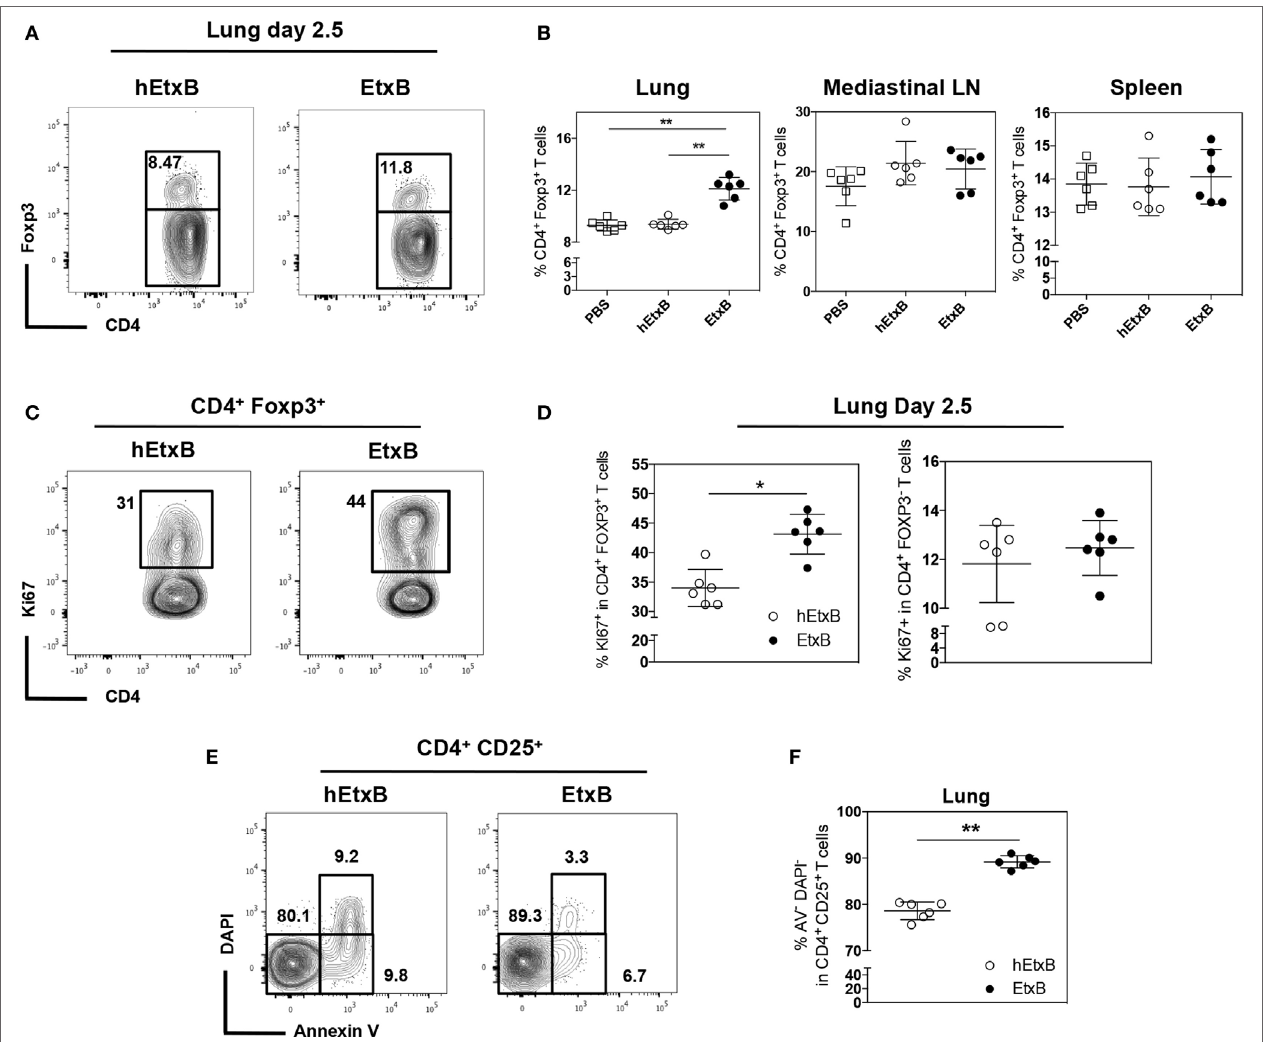
FigUre 1 | intranasal treatment of etxB increases the proliferation of Treg cells . C57BL/6 mice were administered, EtxB (100 μ g/mouse), heat inactivated EtxB (hEtxB, 100 μ g/mouse) or PBS on three consecutive days. On day 2.5 following the last dose, spleen, mediastinal lymph node, and lung were removed and analyzed by flow cytometry. Flow cytometric contour plots (a) and dot plots (B) show the frequency of Foxp3 + regulatory T (Treg) cells in CD4 + B220 − cells. The frequency of Ki67 + proliferating Treg cells or CD4 + Foxp3 − T cells (c,D) and frequency of live (Annexin V − DAPI − ) CD4 + CD25 + cells (e,F) in the lung. Results are from one experiment representative of three independent experiments, with six mice per group. In dot plots, the mean and SD are represented and each circle represents one mouse: white squares PBS treated animals, white dots hEtxB-treated animals, black dots EtxB-treated animals. * p < 0.05 and ** p < 0.005 compared with PBS- or hEtxB-treated mice (Mann–Whitney U